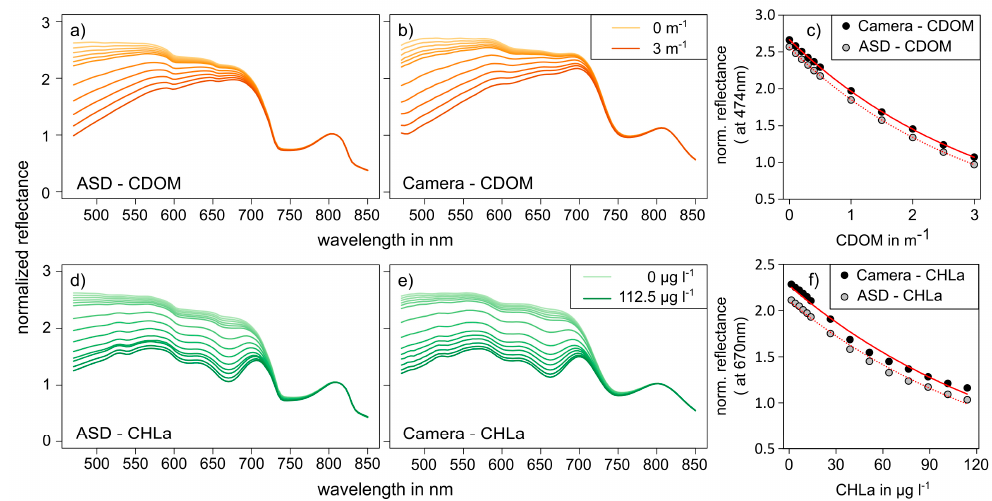
Figure 5. Comparison of experimental laboratory measurements between ASD FieldSpec 4 and UHD 285 hyperspectral camera at various levels of colored dissolved organic matter (CDOM) ( a , b ), and chlorophyll a (CHLa) ( d , e ) concentrations. Panels ( c , f ) show a direct comparison of the measured reflectance at specific key wavelengths sensitive to changes in CDOM and CHLa, respectively.